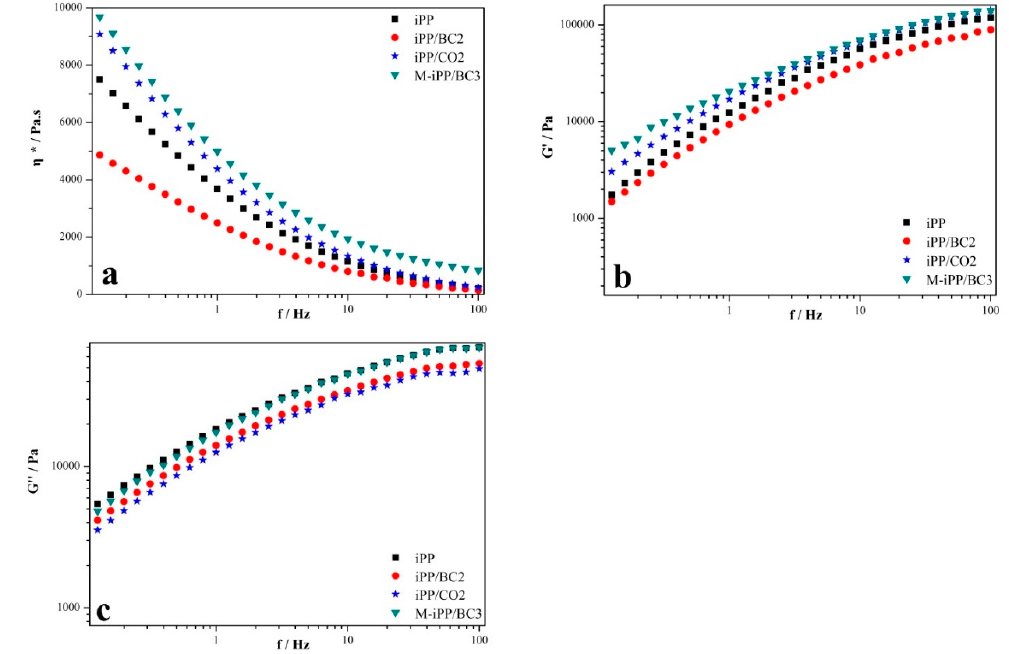
Figure 1. The rheological properties of the iPP/BC composite. (( a ) complex viscosity, ( b ) storage modulus, and ( c ) loss